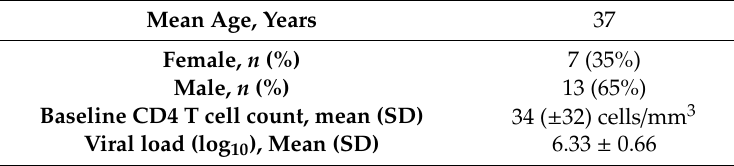
Table 2. Baseline characteristics of the study